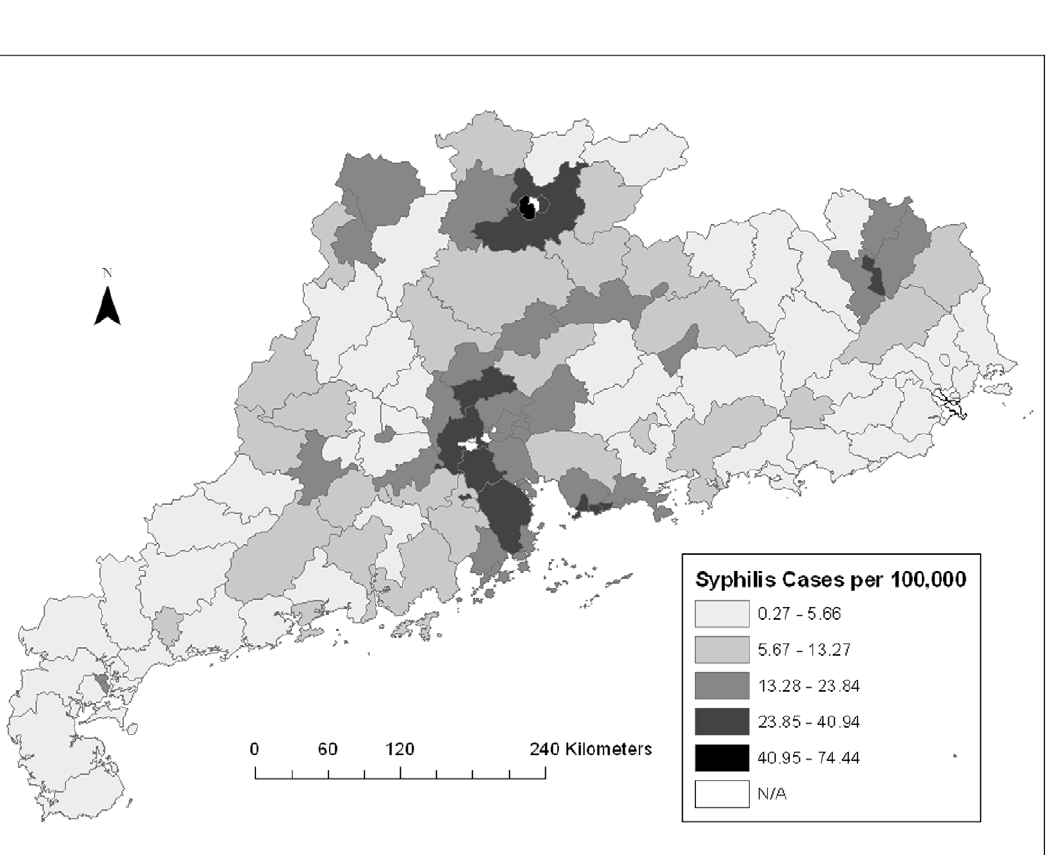
Figure 1. Spatial distribution of syphilis cases per 100,000 adults in Guangdong Province. This figure shows that although syphilis burden is not clustered across the entire Guangdong province, there is higher syphilis burden in the counties in the central region, called the Pearl River Delta. doi:10.1371/journal.pone.0019648.g001 PLoS ONE |